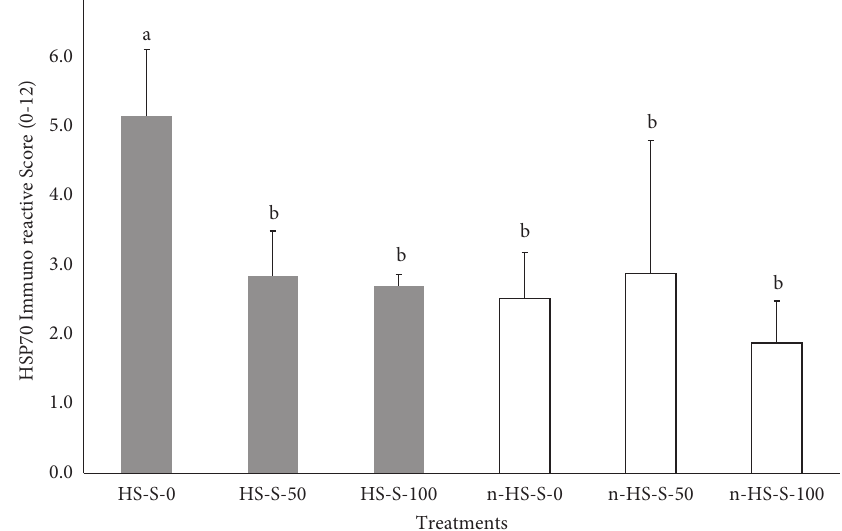
Figure 4: The average score of HSP70 protein staining on chicken kidney tubule tissue that was given Salix leaf extract under heat-exposed and non-heat-exposed conditions. Different superscript letters on the graph showed significant differences ( P < 0 .